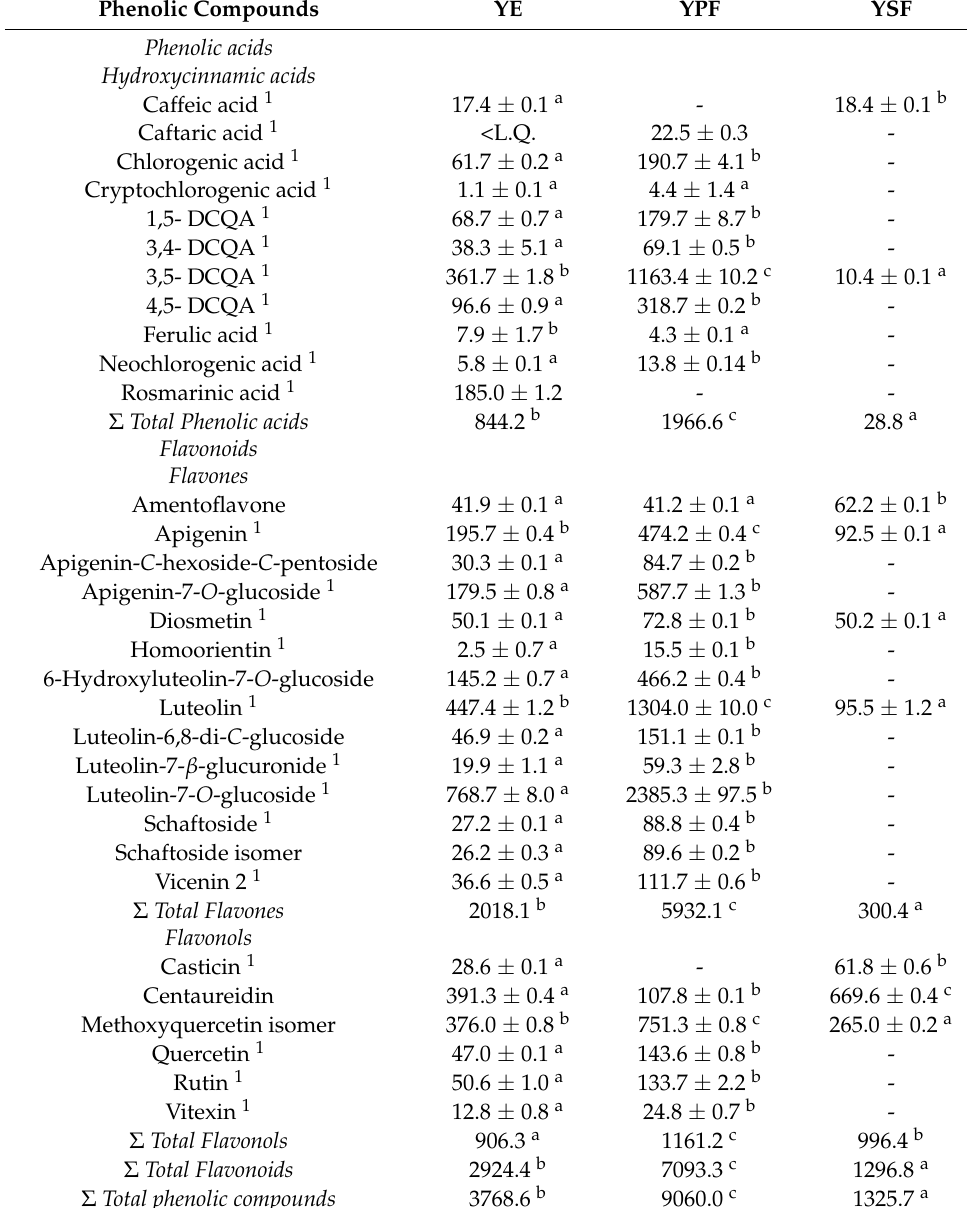
Table 1. Phenolic composition and quantification of YE and its fractions (mg/100 g dry